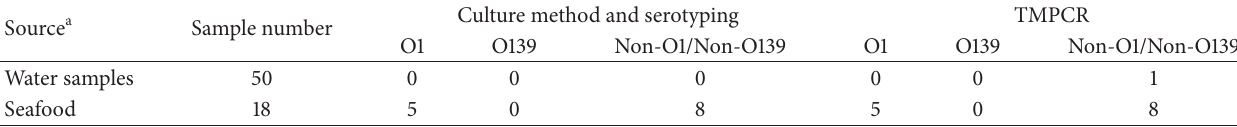
Table 6: Advancement of TMPCR for V . cholera detection using environmental samples.